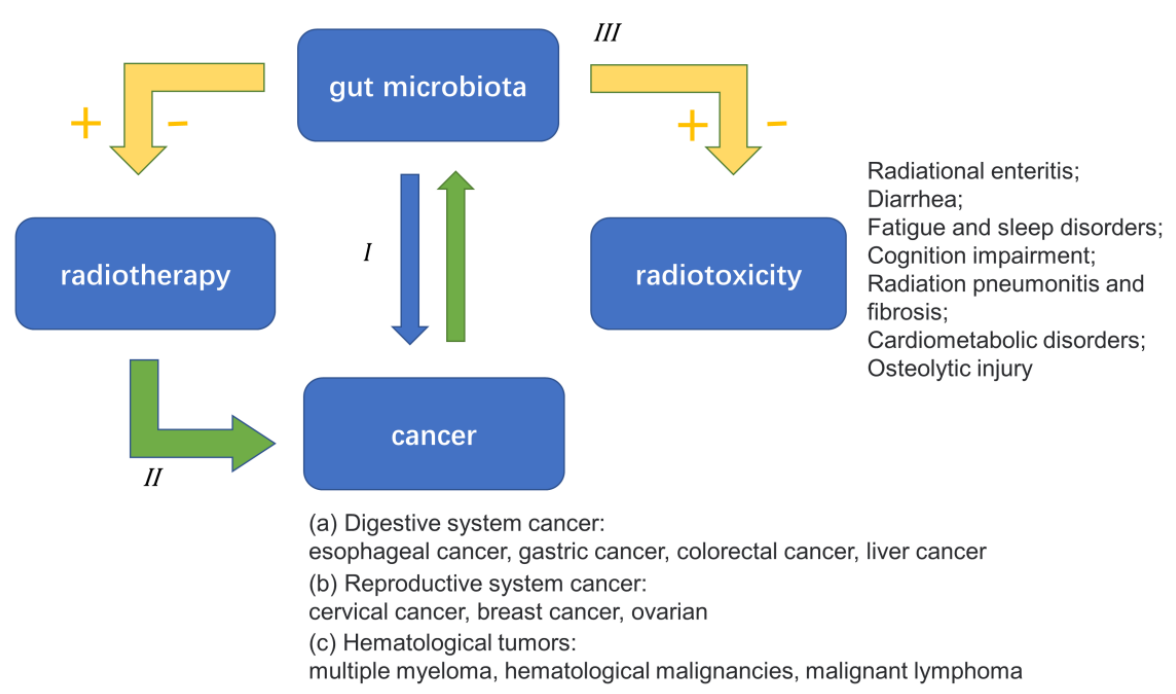
Figure 4. The complicated relationship between the gut microbiota, cancer, and